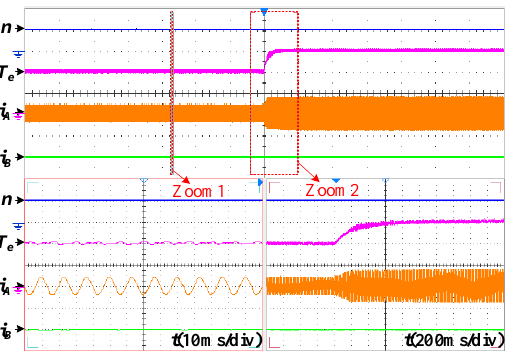
Figure 9. Dynamic responses with the reduced load at phase-A open-circuit fault-tolerant operation. (500 rpm/div, 2 Nm/div, 5 A/div). ( a ) Conventional fault-tolerant FOC. ( b ) Proposed fault-tolerant FOC.